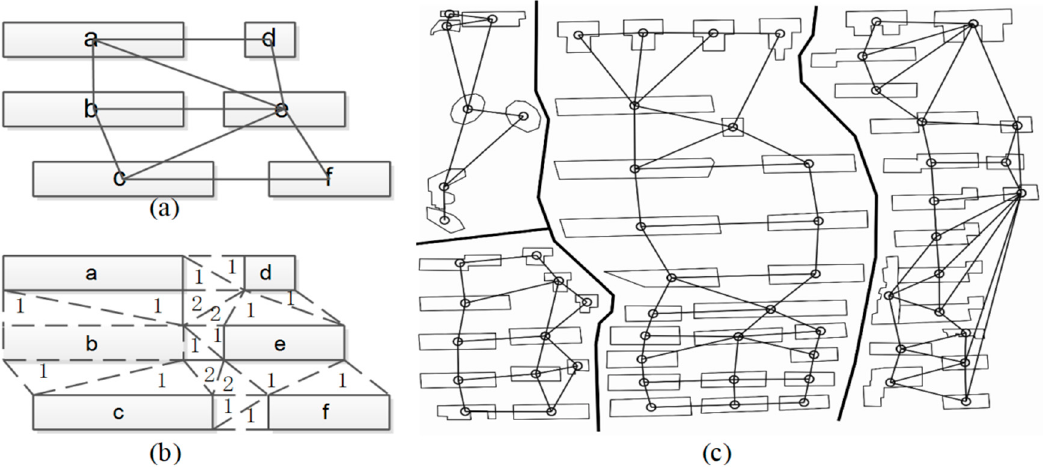
Figure 4. Visibility analysis: ( a ) Delaunay triangulation (DT); ( b ) constrained Delaunay triangulation (CDT); ( c ) preliminary proximity graph.